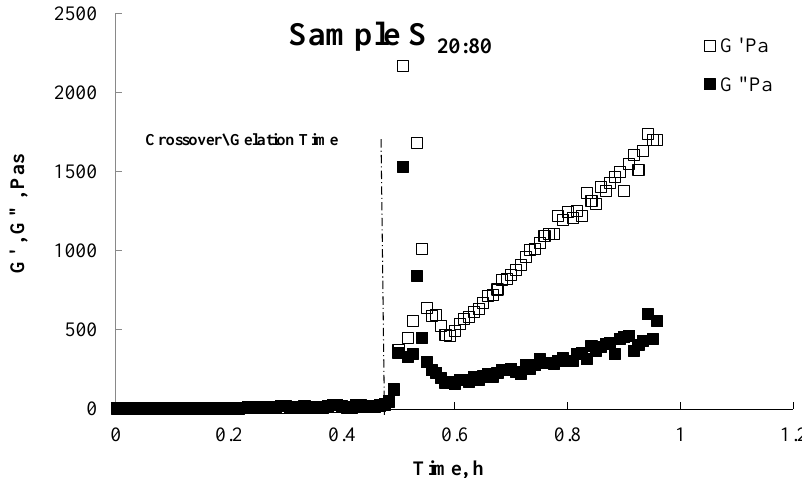
Figure 3. Elastic modulus (G') and viscous modulus (G") of sample S 20:80 (representative for all ratios) as a function of frequency.